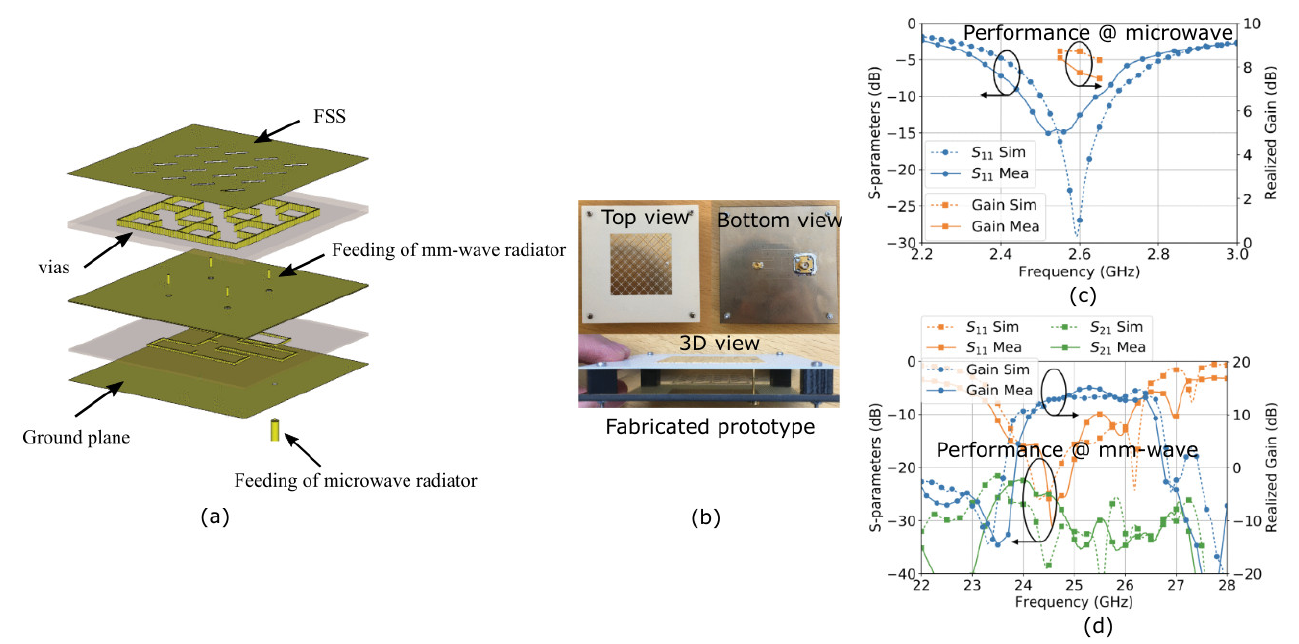
Figure 18. ( a ) Cavity − backed antenna integrated with FSS, ( b ) prototype of the antenna, ( c , d ) are simulated and measured S − parameters and gain at the lower and upper band [99].